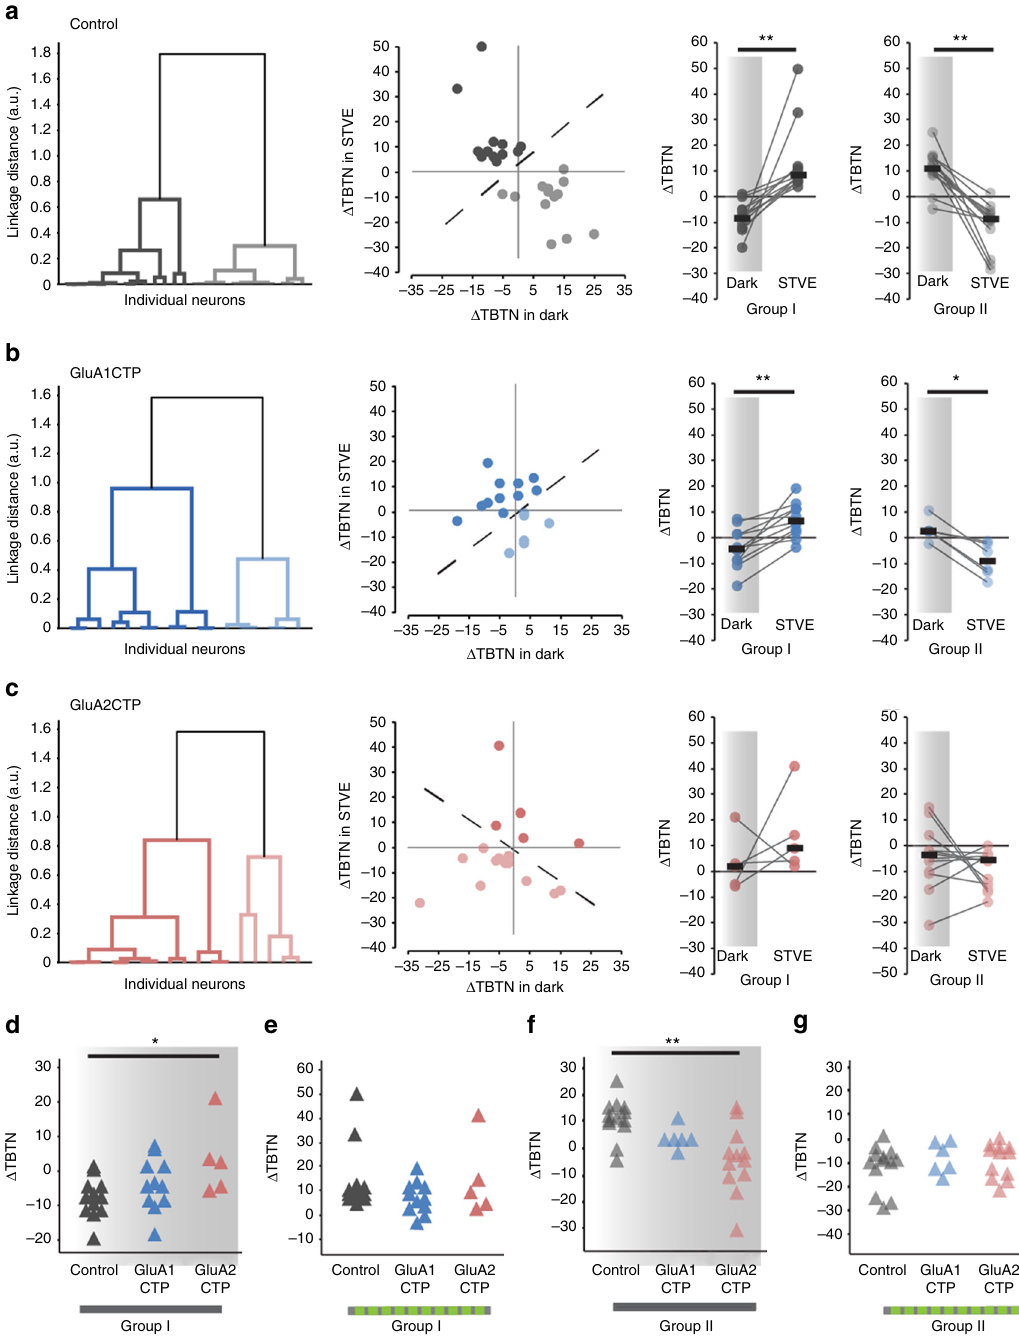
Fig. 5 GluA2CTP expression disrupted the bimodal experience-dependent structural plasticity of inhibitory neurons. a Left: Dendrogram of unsupervised hierarchical cluster analysis of control inhibitory neurons based on changes in TBTN ( ΔΤΒΤΝ ) in STVE versus dark. Middle: Scatter plots of Δ TBTN in response to STVE versus dark in individual neurons for Group I and II inhibitory neurons. Right: Summary of Δ TBTN in dark and STVE for control Group I and II neurons. b Cluster analysis of GluA1CTP-expressing inhibitory neurons. c Cluster analysis of GluA2CTP-expressing inhibitory neurons. * P < 0.05, ** P < 0.01, Wilcoxon sign rank test. d , g Summary data of Δ TBTN in response to dark ( d , f ) and STVE ( e , g ) in Group I ( d , e ) and Group II ( f , g ) inhibitory neurons. * P < 0.05, Kruskal – Wallis test with post hoc Mann – Whitney U